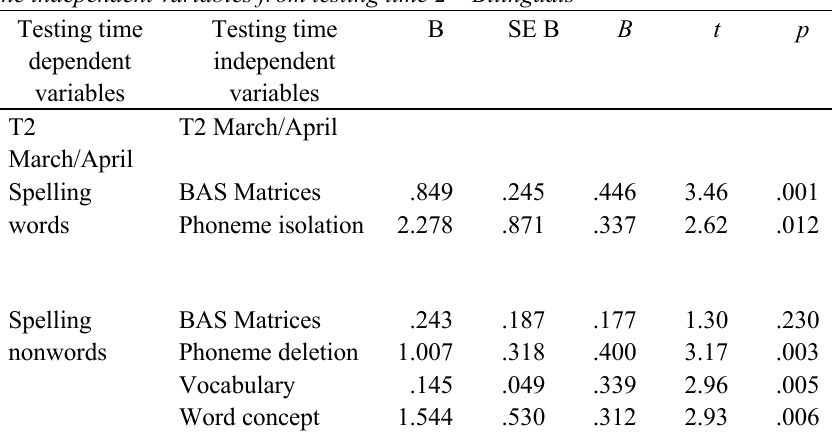
Table 6. Multiple regression analyses predicting spelling at testing times 2 an 3